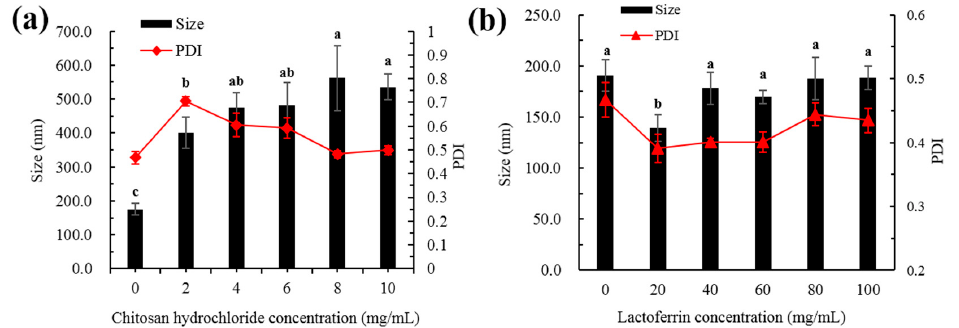
Figure 1. Particle size and PdI of astaxanthin liposomes at different concentrations of CH ( a ) and LF ( b ). Different lowercase letters on the column chart indicate significant differences between groups ( p < 0.05).